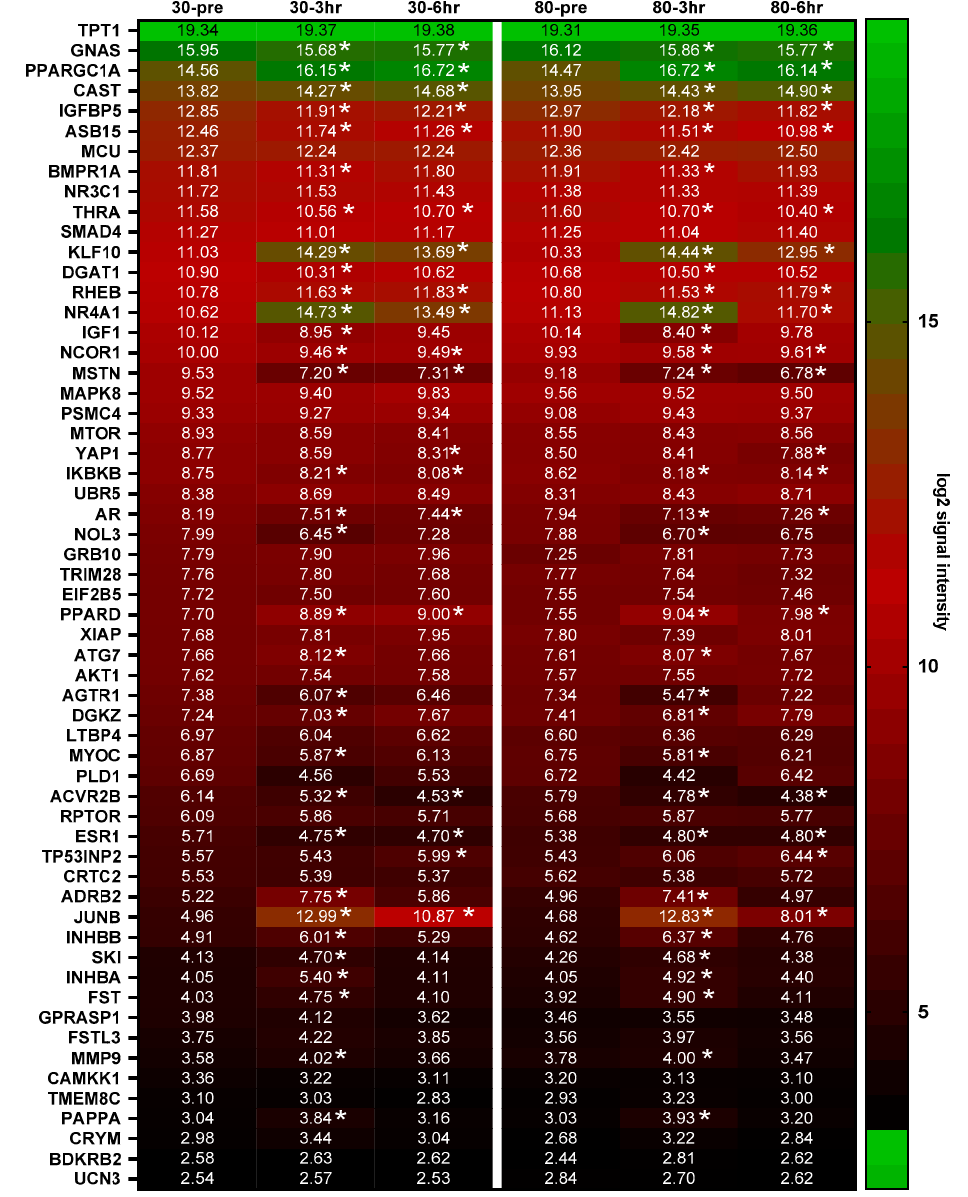
Figure 1. Heat map of mRNAs related to hypertrophy and their acute responses to the 30 Fail or 80 Fail bouts. These data show the log 2 expression of the 58 mRNAs related to skeletal muscle hypertrophy. Genes are sorted (top to bottom) based on basal expression at the 30 Fail PRE condition. Notably, only significant time effects (not interaction effects) were evident (denoted by *, p < 0.01).